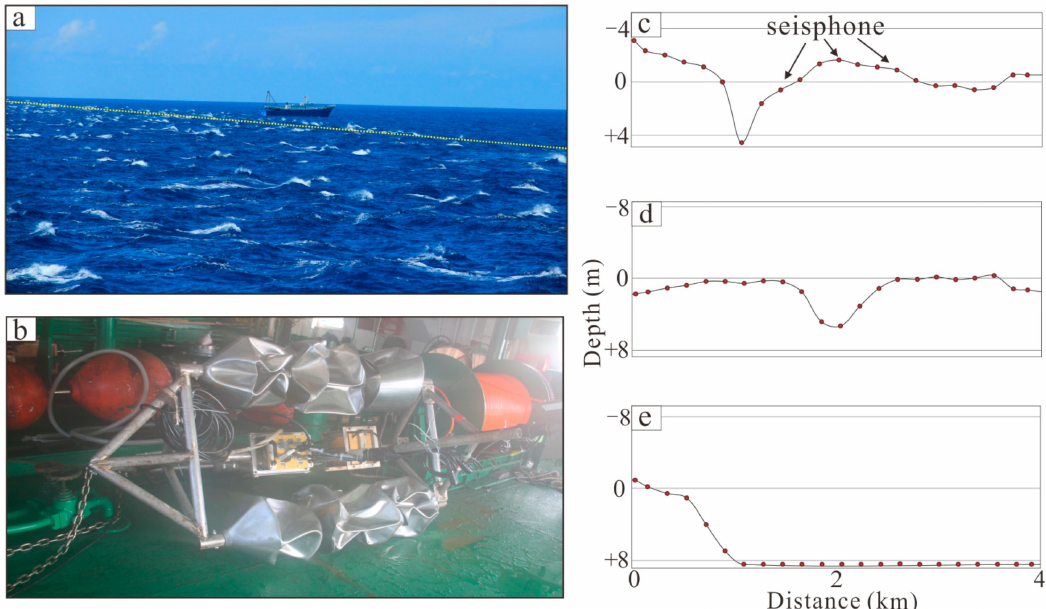
Figure 2. ( a ) Turbulence zones observed on the sea surface; ( b ) cable tails damaged by turbulence in deep water; ( c – e ) turbulence flow influences the location of the seisphones (in general, without the influence of extreme sea conditions, each seisphone should present an approximate horizontal line, with a fluctuation of no more than 1